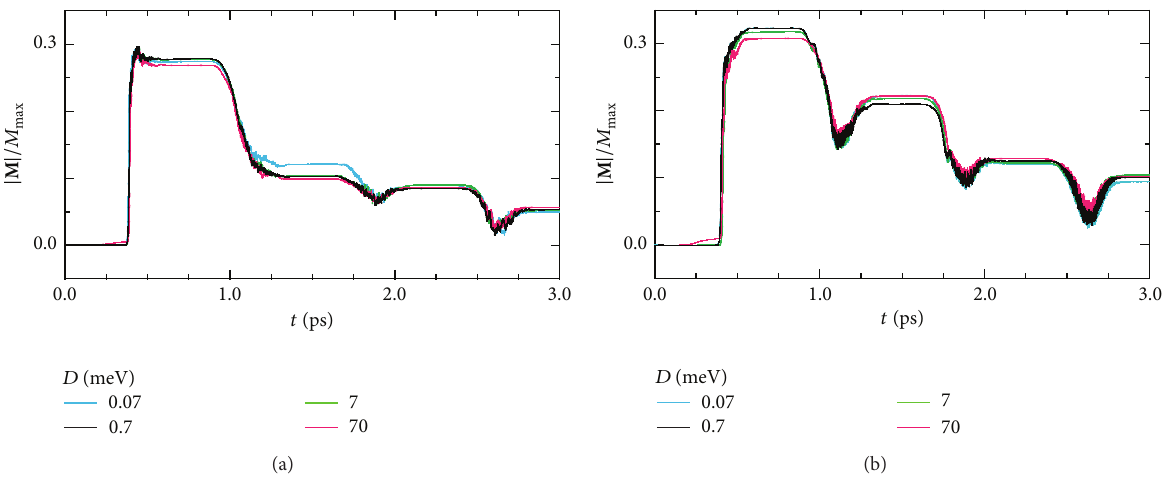
Figure 5: Manipulation of the magnetization by applying successive pump laser pulses in the form of (15) with (a) A 0 ‖ a and (b) A 0 ‖ c in the presence of the DM interaction ( 𝐷 = 0.07, 0.7, 7,70 meV), where 𝑀 max is the saturated